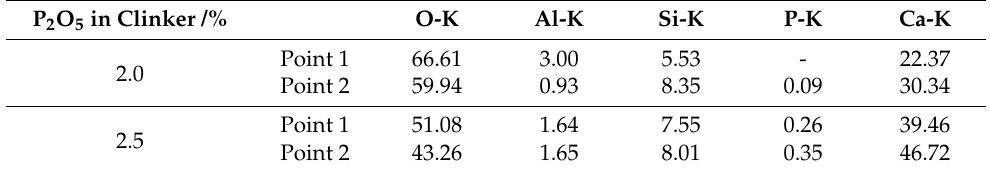
Table 4. Chemical composition of C-S-H in cement pastes with 2.0% and 2.5% P 2 O 5 by